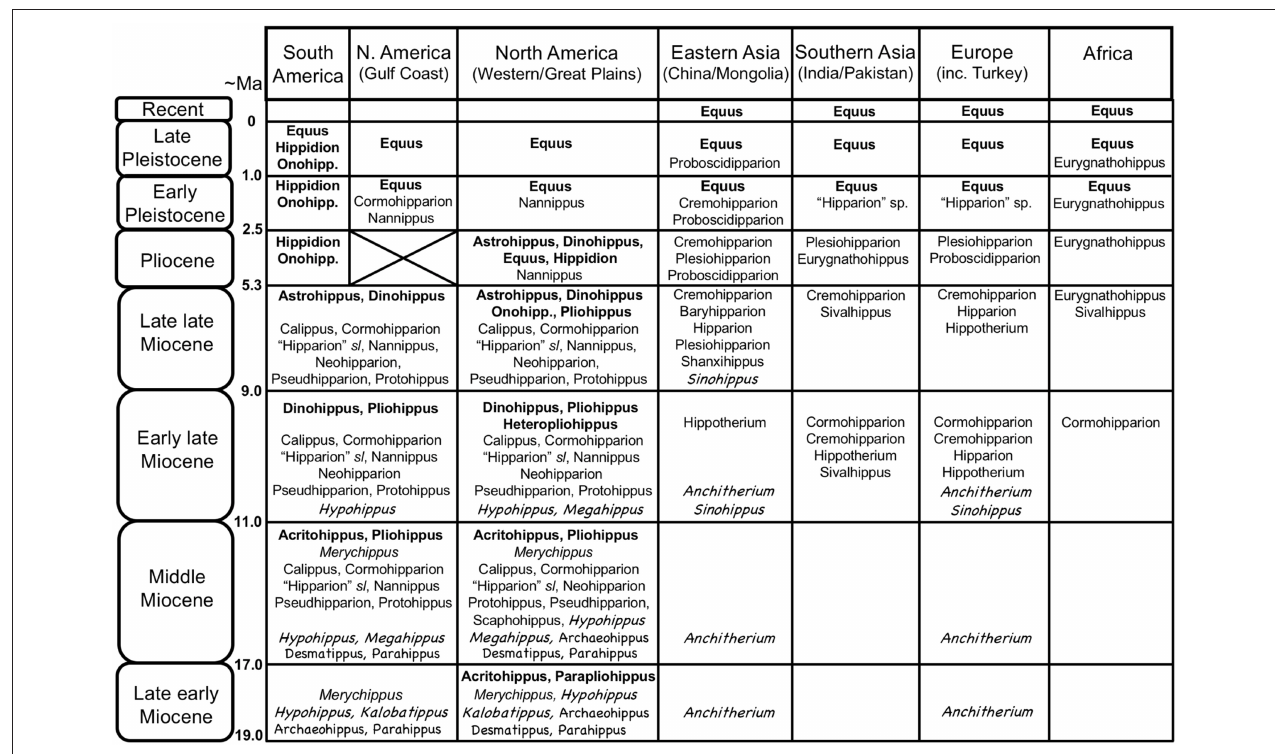
FIGURE 3 | Global distribution of Neogene equid genera, showing the diversity of the different families/subfamilies. Original drawing by CMJ, final figure rendered by James G. Napoli. Key to equid taxonomy: Roman type = Equinae: bold face = Equini (Onohipp. = Onohippidium ); regular type = Hipparionini (including Protohippini) ( sl = sensu lato ); italics = “ Merychippus ” sensu stricto (i.e., basal species, more derived species not shown, but none persist past the middle Miocene). Chalkboard type = Anchitheriinae: regular type = stem Equinae anchitheres; italics = Anchitheriini. Although anchitheriine equids are only considered briefly in this paper, their distribution in time and space is interesting, and their persistence alongside of the Miocene Equinae is often disregarded. Information from Janis et al. (2008), MacFadden (2013), Salesa et al. (2004), the NOW database, Fossilworks, and Bernor et al. (1996). Divisions within epochs are approximate to accommodate both North American Land Mammal Ages and Eurasian MN/MQ zones + Land Mammal Ages. Late Pleistocene = Rancholabrean/MQ2; early Pleistocene = Irvingtonian + late Blancan/MQ1; Pliocene = early Blancan ( + very latest Hemphillian)/MN14-16/Ruscinian (no faunas known from the North American Gulf Coast); late Miocene = Hemphillian/MN13-11/Turolian + late Vallesian; early late Miocene = Clarendonian/MN9-10/early Vallesian + late Astracean; middle Miocene = Barstovian/earliest Clarendonian/MN5-8/Astracean + late Orleanian; late early Miocene = Hemingfordian/MN3(later part)-4/middle